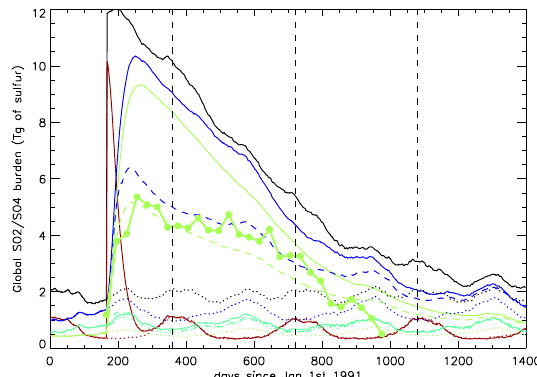
Figure 2. Time series of the global burden (in Tg of sulfur) of SO 2 (red), total sulfur (includes both SO 2 and aerosol, black), aerosol sulfur (dark blue) for runs A_Control20 (solid lines), B_Control10 (dashed lines), and C_noPinatubo (dotted lines). Integrated aerosol sulfur burdens in the UTS and lower–middle troposphere (deter- mined by above or below 400hPa) are also shown with green and aqua lines, respectively. The stratospheric aerosol burden derived by Baran and Foot (1994) using HIRS measurements is shown by the green line with filled circles, assuming 75% sulphuric acid by